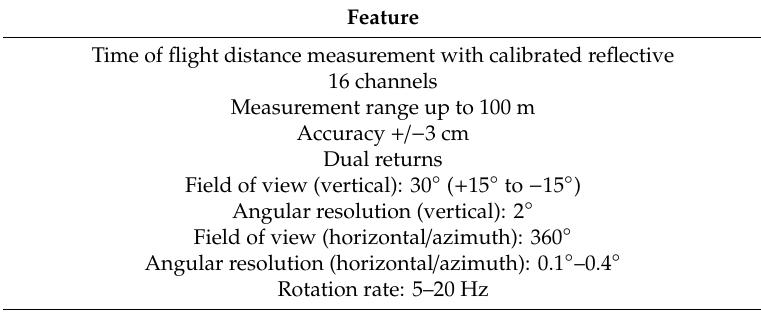
Table 2. 16 L LIDAR characteristics.